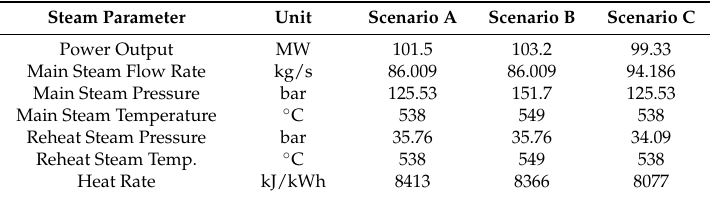
Table 4. Steam parameters for power plants fired by off-gases under scenario A, scenario B (Practical Optimum Conditions) and C (generation of 100 MW power and 45 tons of steam